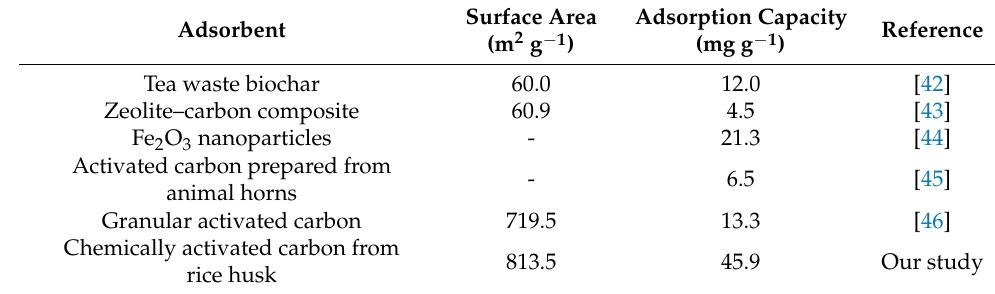
Table 1. Comparison of surface area and adsorption capacity of various adsorbents.